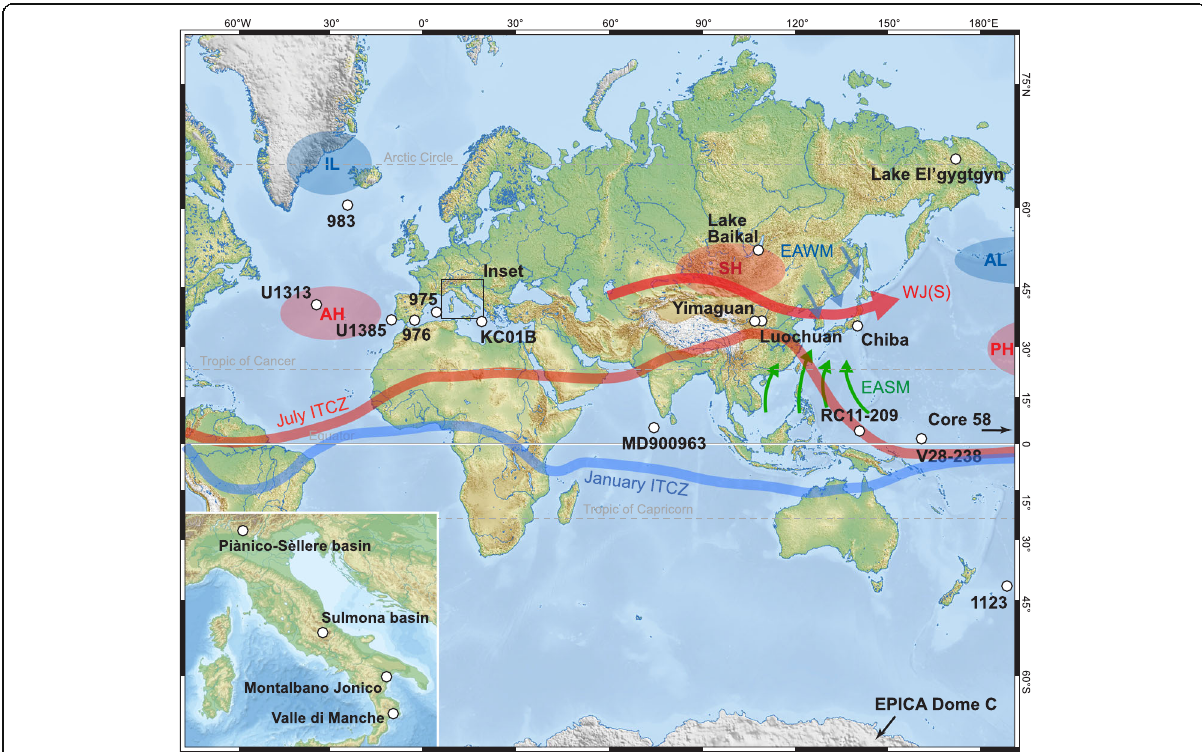
Fig. 4 Location of sites discussed in the text and present atmospheric features. ODP Site 983 Gardar Drift, Iceland Basin; IODP Site U1313 upper western flank of the Mid-Atlantic Ridge, central North Atlantic; IODP Site U1385 southwest Portuguese margin; ODP Site 976 Alboran Sea; ODP Site 975 western Mediterranean Sea; Core KC01B Ionian Sea; Core MD900963 tropical Indian Ocean; Lake Baikal, SE Siberia; Yimaguan and Luochuan, Chinese Loess Plateau; Chiba composite section, Japan; Vema 28-238 and RC11-209 cores, western equatorial Pacific Ocean; ODP Site 1123 Chatham Ridge, South Pacific; EPICA Dome C ice core (75° 06 ′ S, 123° 21 ′ E, location is off the map); Core 58 of Arrhenius (1952), eastern equatorial Pacific Ocean (6° 44 ′ N, 129° 28 ′ W; location is off the map); inset shows important Italian sites. The Westerly Jet (WJ) during summer (S), East Asian Summer/Winter Monsoon (EASM/ EAWM), and summer/winter variation in the position of the Intertropical Convergence Zone (ITCZ) adapted from Cheng et al. (2012) and Liu et al. (2015); the Siberian High (SH) and Aleutian Low (AL) are primarily winter atmospheric pressure systems; the AL and Pacific High (PH) form the North Pacific Oscillation; the Islandic Low (IL) and Azores High (AH) form the North Atlantic